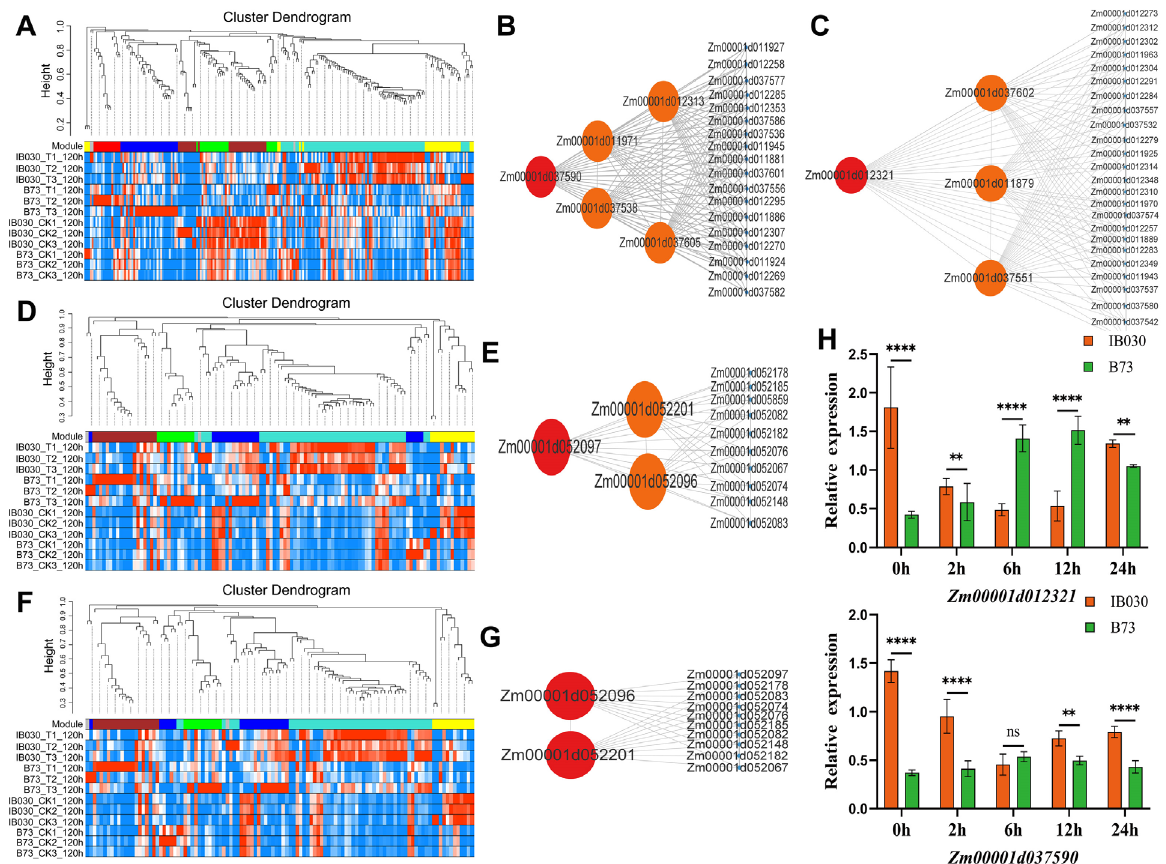
Figure 5. The identified modules and regulatory networks of hub genes in this study. Note: ( A ) Hierarchical clustering tree diagram of modules; ( B ) green module showing the regulatory network of the 5 hub genes; ( C ) regulatory network of the 4 hub genes in the yellow module; ( D ) hierarchical clustering tree diagram of modules; ( E ) regulatory network of a hub gene in the yellow module; ( F ) hierarchical clustering tree diagram of modules; ( G ) regulatory network of two hub genes in the yellow module; ( H ) relative expression analysis of candidate genes. Note: SFW, SDW, and REC represent seedling fresh weight, seedling dry weight, and relative electrical conductivity, respectively. ** indicates significance at 0.01 level, **** indicates significance at 0.001 level, and ns indicates not significance.